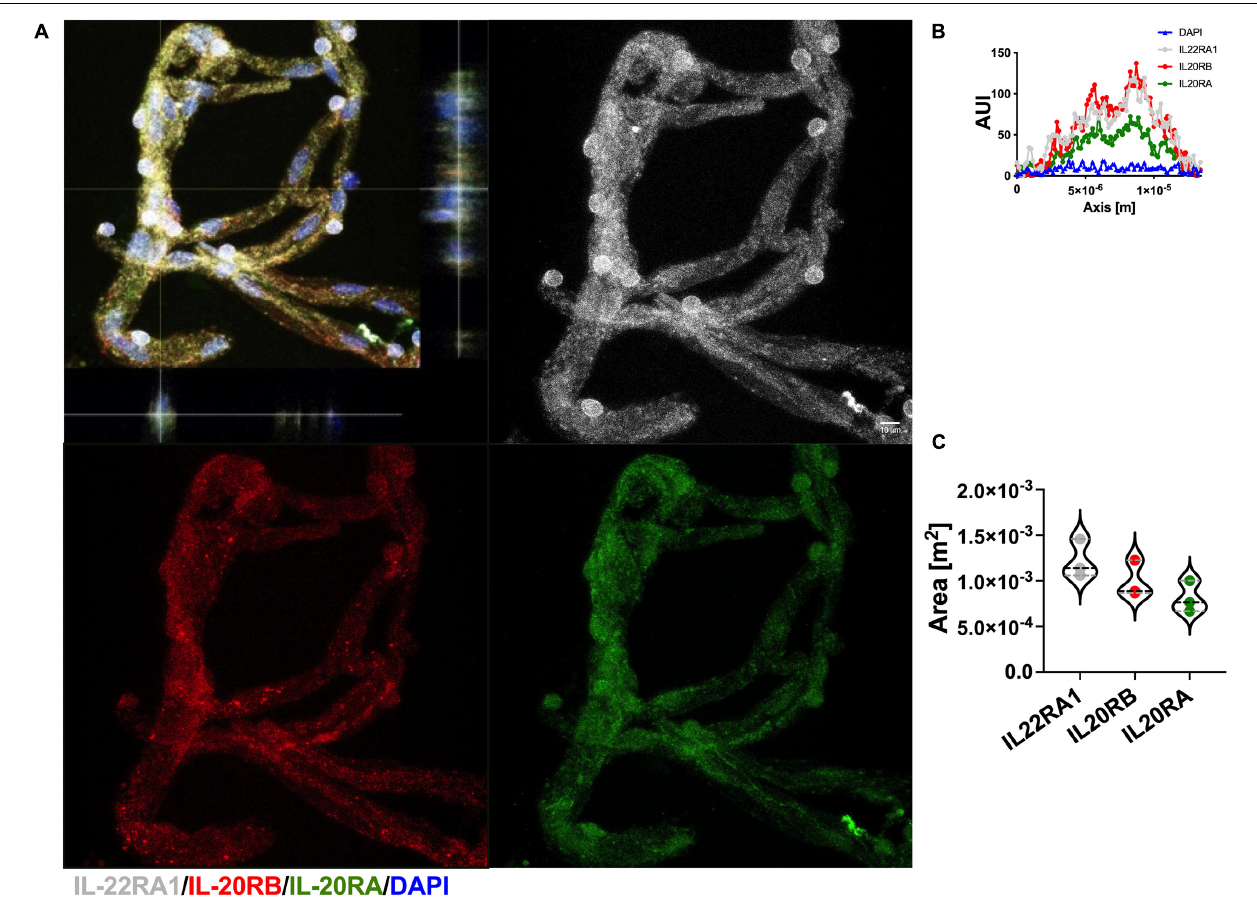
FIGURE 6 | Human CNS microvasculature expresses IL-20 receptor subunits. Human microvessels were isolated from PVWM post-mortem biopsies, n = 3, to elucidate IL-20 receptor subunits protein expression by immunolabeling for IL-22RA1 (white), IL-20RB (red), IL-20RA (green), and DAPI (blue), scale bar = 10 µ m (A) . Histogram analysis was performed to 50 microvessels per specimen to determine AUI and AUC of each receptor subunit (representative AUI vs. axis plot histogram, B ). Although AUC means exhibit a trend IL-22RA1 > IL-20RB > IL-20RA, one-way ANOVA analysis followed by Sidak’s post hoc test showed that mean AUC differences between subunits are not statistically significant (mean ± SD IL-22RA1: 1.2 × 10 − 3 ± 2.1 × 10 − 4 , IL-20RB: 9.9 × 10 − 4 ± 2.0 × 10 − 4 , and IL-20RA: 8.1 × 10 − 4 ± 1.7 × 10 − 4 , C ). Results are shown as mean ±